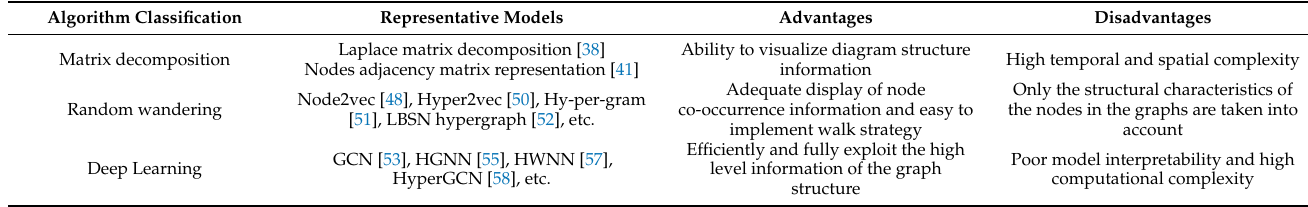
Table 3. Comparison of different graph embedding methods. Algorithm